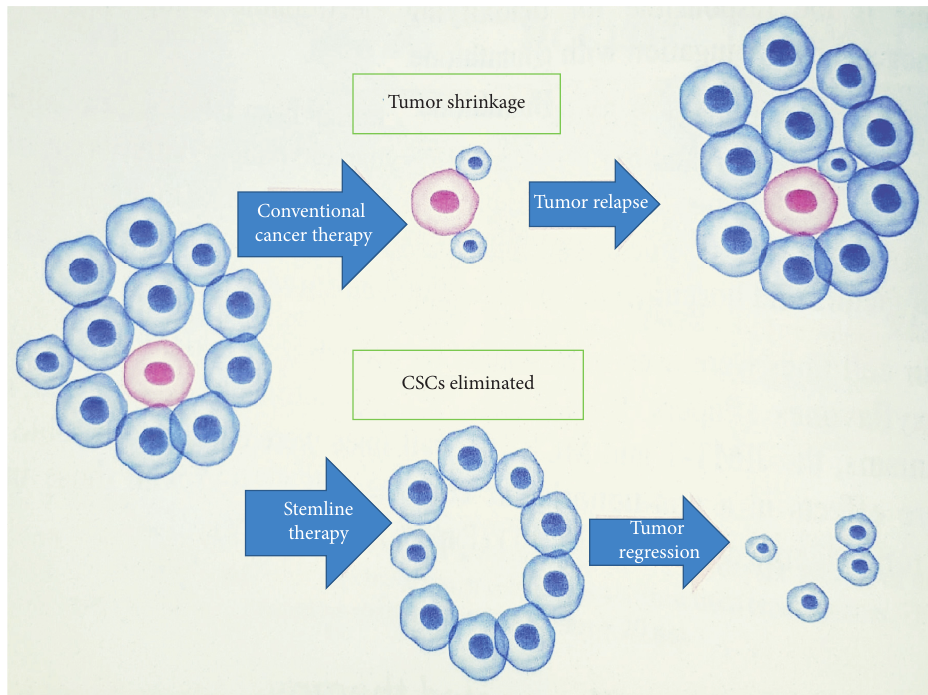
Figure 1: Graphic elucidation of the theory of CSC-based therapeutics. The CSCs (pink) are resistant to conventional therapeutics than their nontumorigenic counterparts (blue). The bulk tumor initially shrinks by the conventional therapeutics, though it repopulates by the virtue of treatment-resistant CSCs. If the CSCs are eradicated, on the other hand, the tumor regresses and eventually